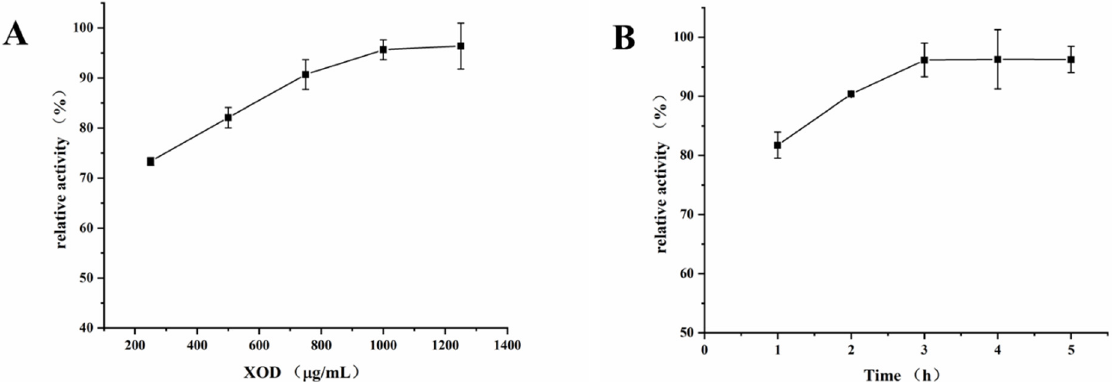
Figure 3. Effects of XOD immobilization time ( A ) and XOD amount ( B ) on the activity of PDA@HF-immobilized XOD (the optimal activities of the immobilized enzyme counterpart were taken as 100%).